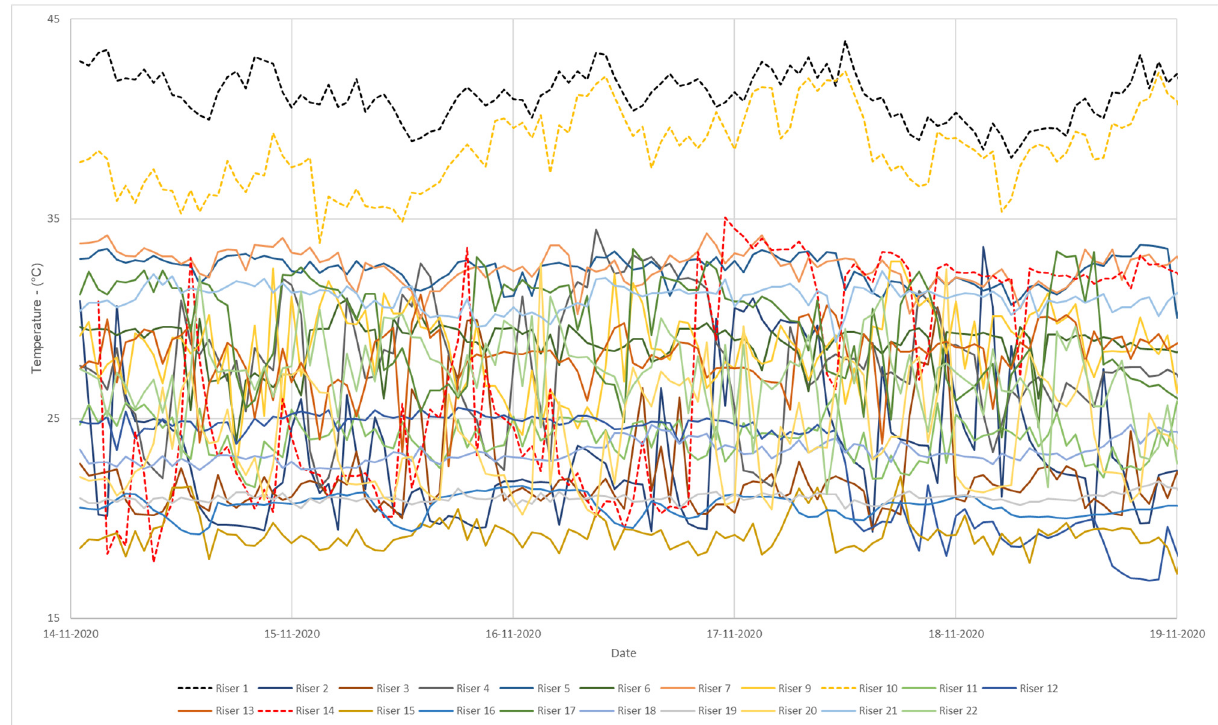
Figure 15. Return temperature measurements from all risers in Building B, 14/11/2020–19/11/2020.